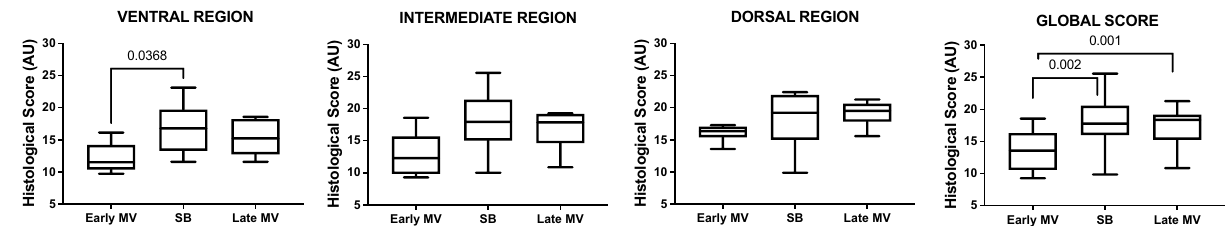
Figure 7. Regional and global histological lung injury score. MV mechanical ventilation, SB spontaneous breathing, AU arbitrary units. * p < 0.05.